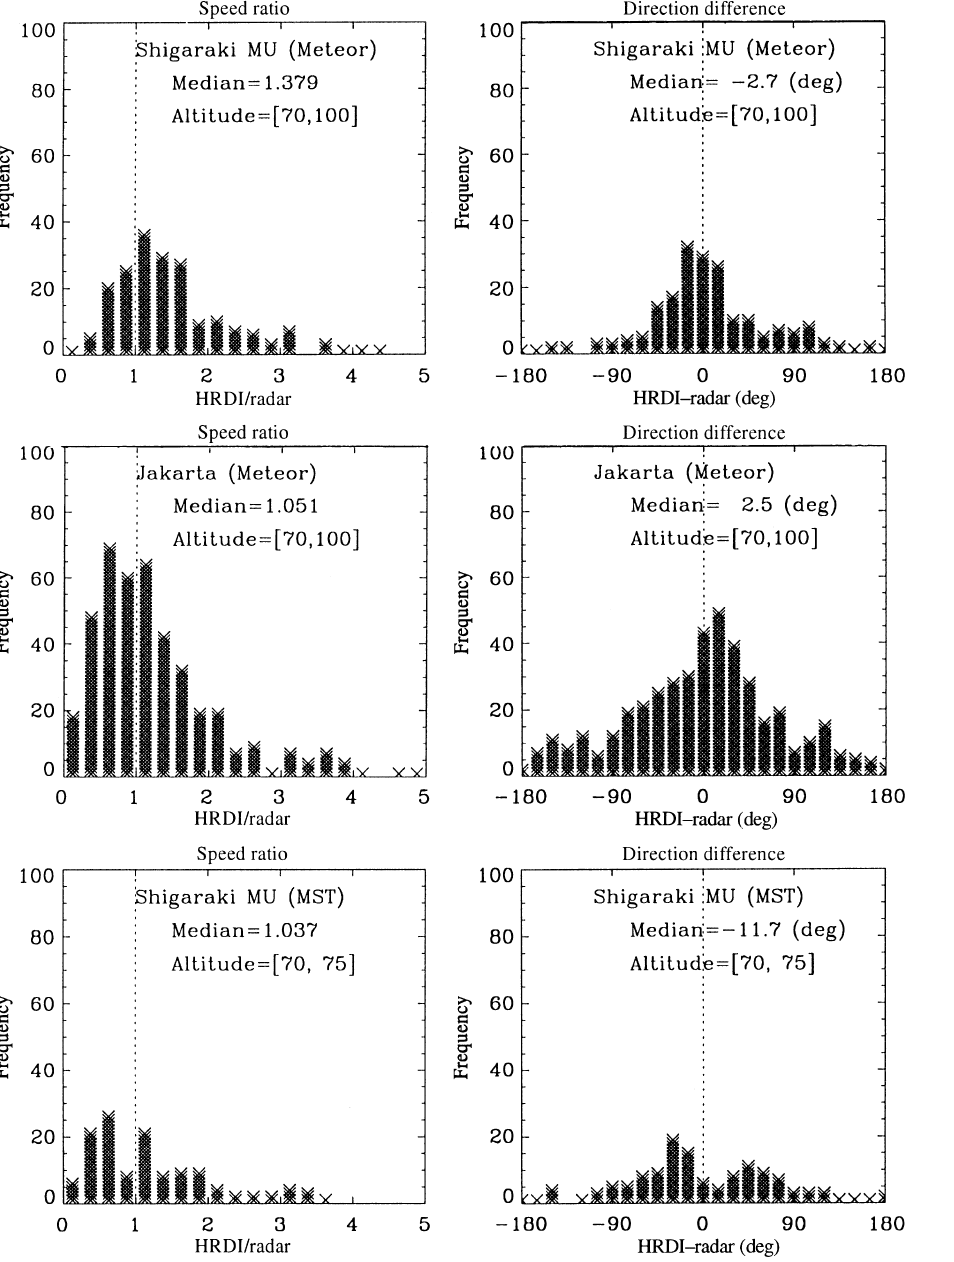
Fig. 5. Histograms of the speed ratio (HRDI/radar) and the direction di(cid:128)erence (HRDI (cid:255) radar). The altitude of the samples ranges from 70 to 100 km for meteor radars and from 70 to 75 km for MST mode MU